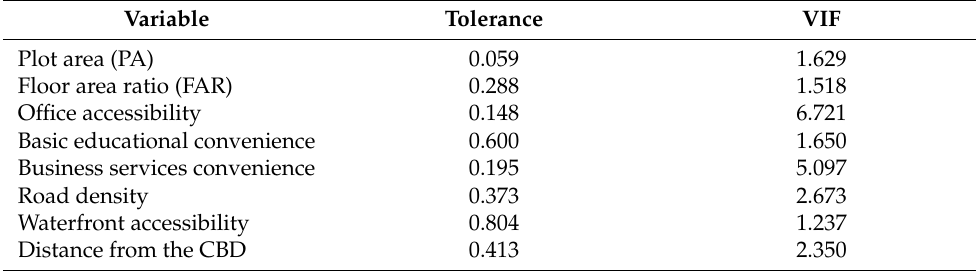
Table 2. VIF collinearity diagnosis results.